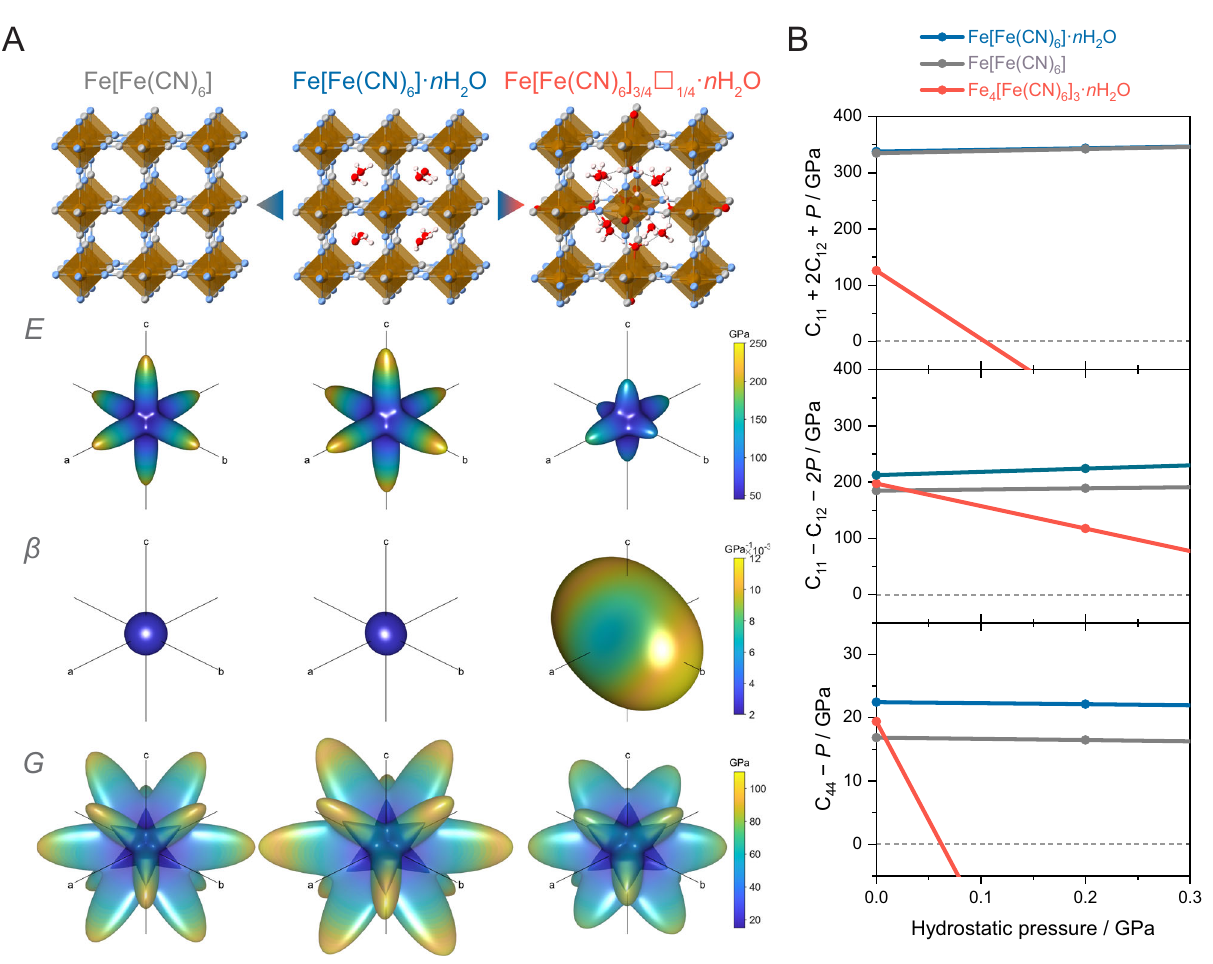
Fig. 5 Elastic tensor analysis. A Spatial dependence of Young ’ s modulus ( E ), linear compressibility ( β ), and shear modulus ( G ) of Fe[Fe(CN) 6 ], Fe[Fe(CN) 6 ]·2H 2 O, and Fe[Fe(CN) 6 ] 3/4 □ 1/4 ·3.5H 2 O. Since the G cannot be directly represented in 3D space, plots represent values range by enclosing the translucent maxima surface on an opaque minima surface. B Evolution of the stability criteria for compression ( λ = C 11 + 2C 12 + P ), ( λ = C 11 − C 12 − 2 P ), and shear ( λ = C 44 − P ) of Fe[Fe(CN) 6 ] (grey), Fe[Fe(CN) 6 ]·2H 2 O (blue), and Fe[Fe(CN) 6 ] 3/4 □ 1/4 ·3.5H 2 O (red) as a function of hydrostatic pressure. C 11 , C C 12 , and 44 are the moduli for axial compression, dilation on compression, and shear, respectively. The dashed line indicates the stability limit for each mode (unstable when λ < 0). Fe[Fe(CN) 6 ] represents the effect of the absence of interstitial water, while Fe[Fe(CN) 6 ] 3/4 □ 1/4 ·3.5H 2 O describes the contribution of the hexacyanometallate vacancies. Source data are provided as a Source Data fi